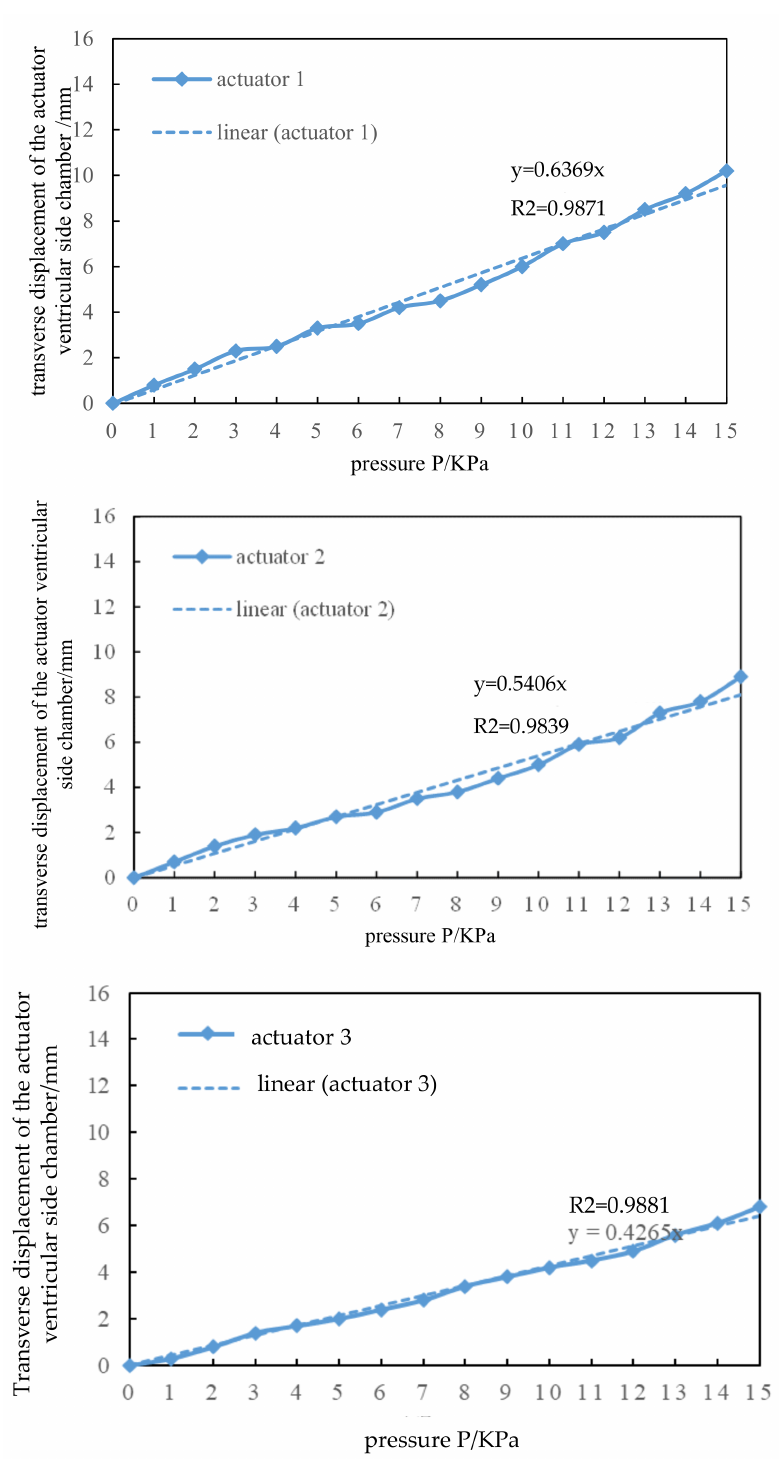
Figure 10. Relationship between lateral displacement and pressure of ventricular side chamber in direct ventricular assist devices. (R2 = 0.9871, R2 = 0.9839, R2 =